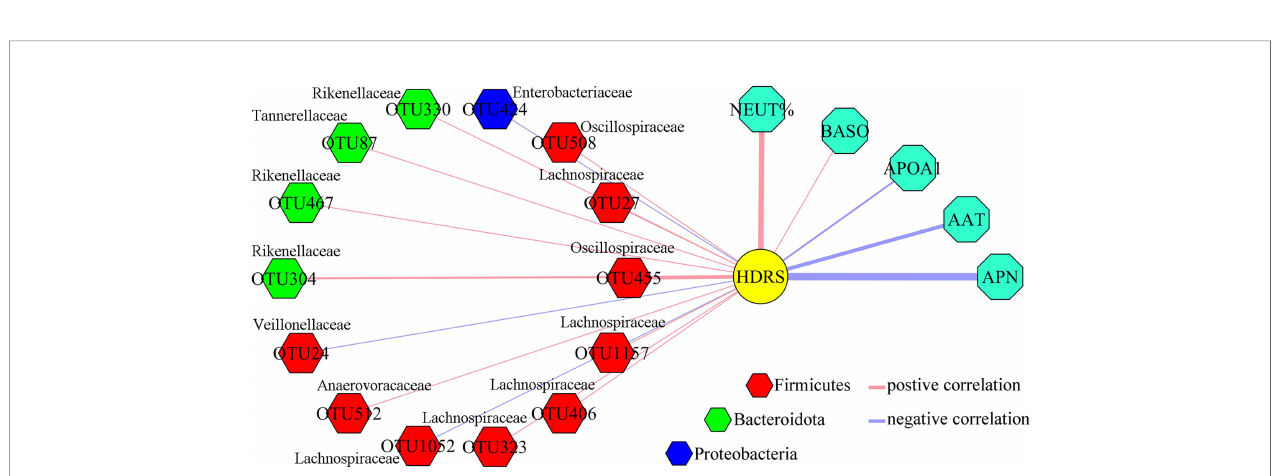
FIGURE 4 | Correlations between differential OTUs and differential in fl ammation-related factors. Most of differential OTUs signi fi cantly related to differential in fl ammation- related factors belonged